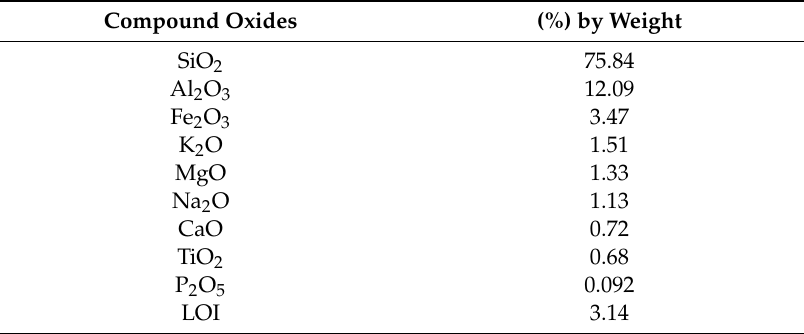
Table 2. Chemical Composition of